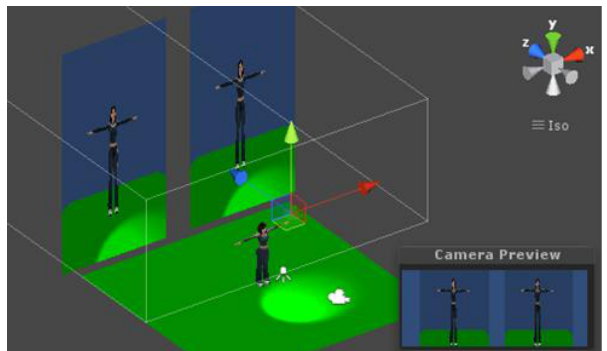
Figure 16. Stereoscopic projection using Unity3D camera-to-texture feature